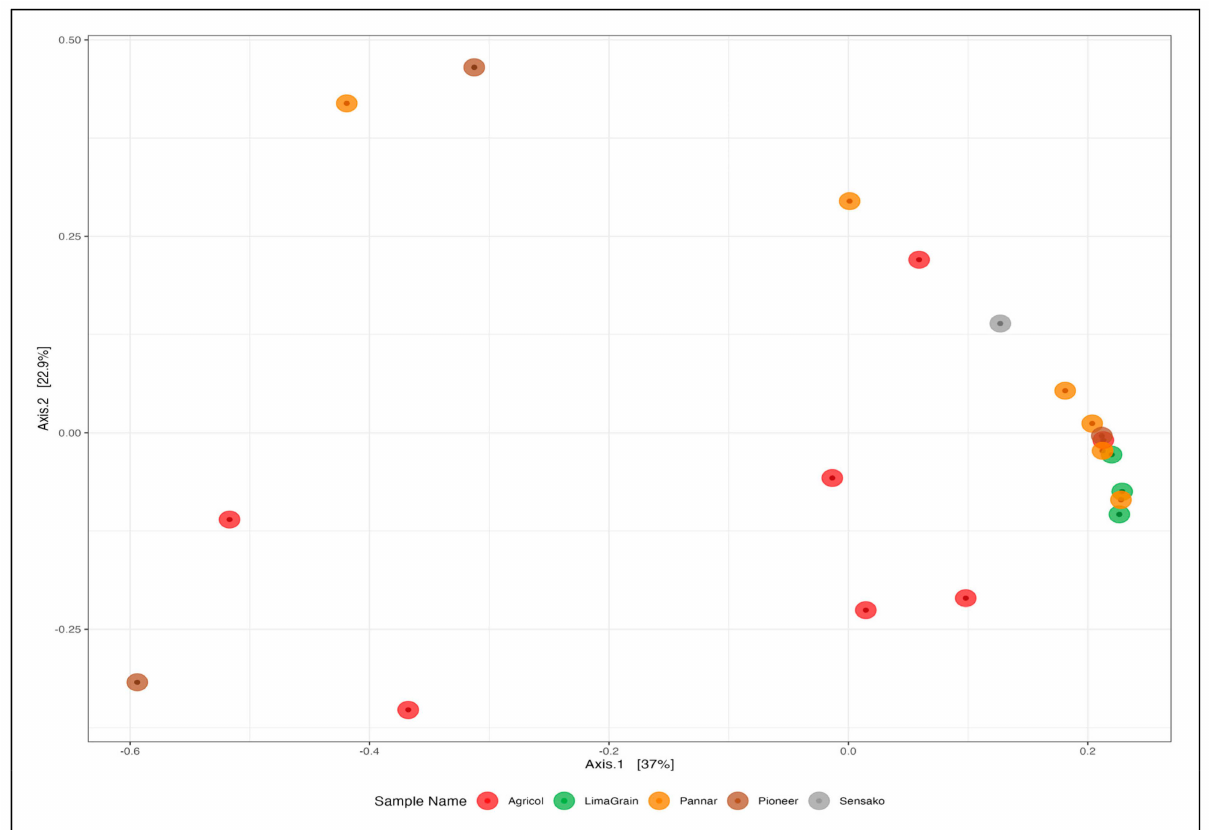
Figure 12. PCoA plot of beta diversity of bacteria (based on Bray-Curtis dissimilarities) at the ASVs level of sunflower seeds. The PCoA data revealed that the first two PCoA components explained 22.9% and 37% of the variation,